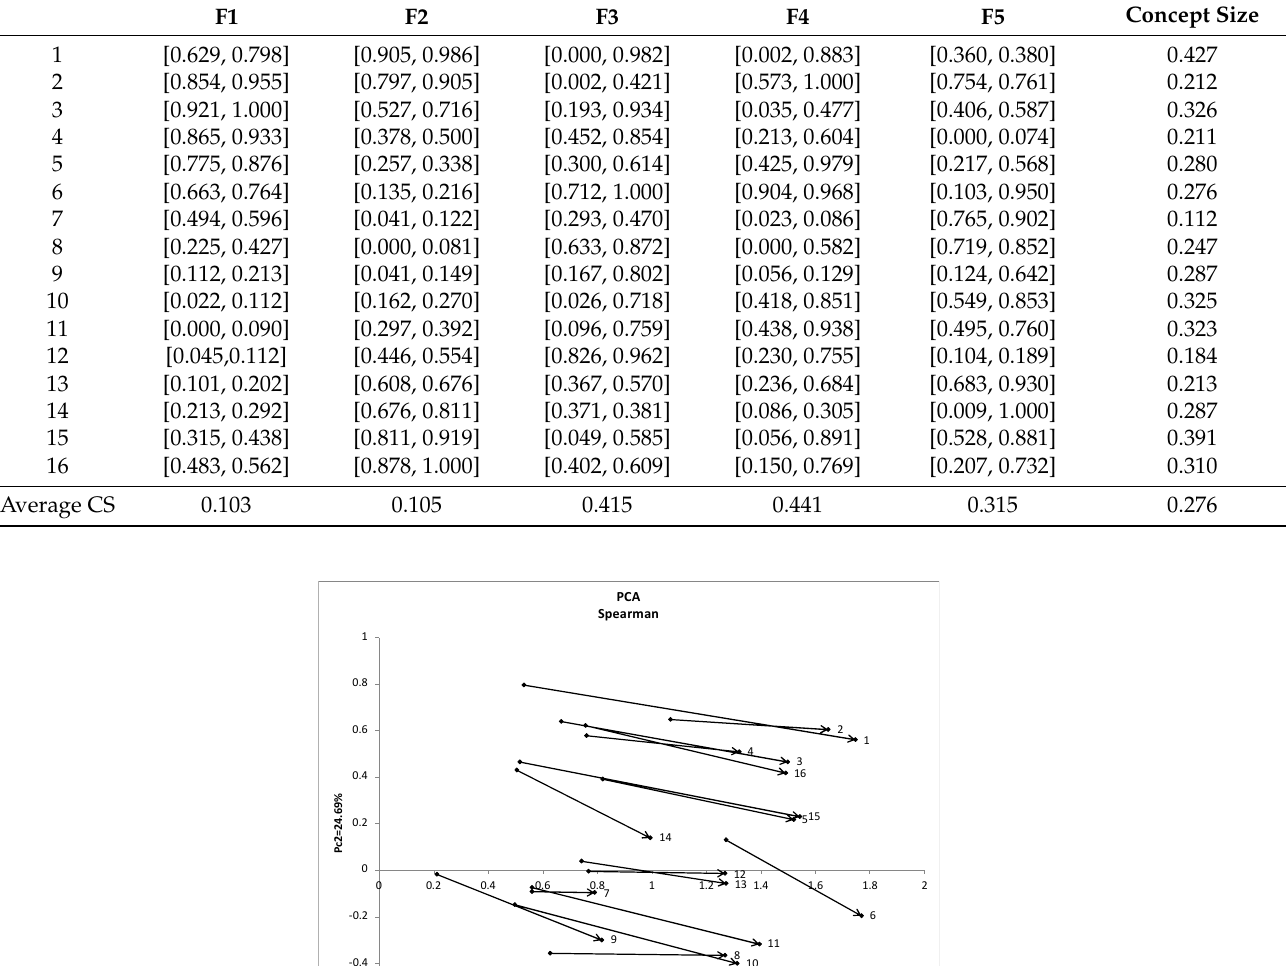
Figure 5. Oval data. Table 3. Oval artificial data.